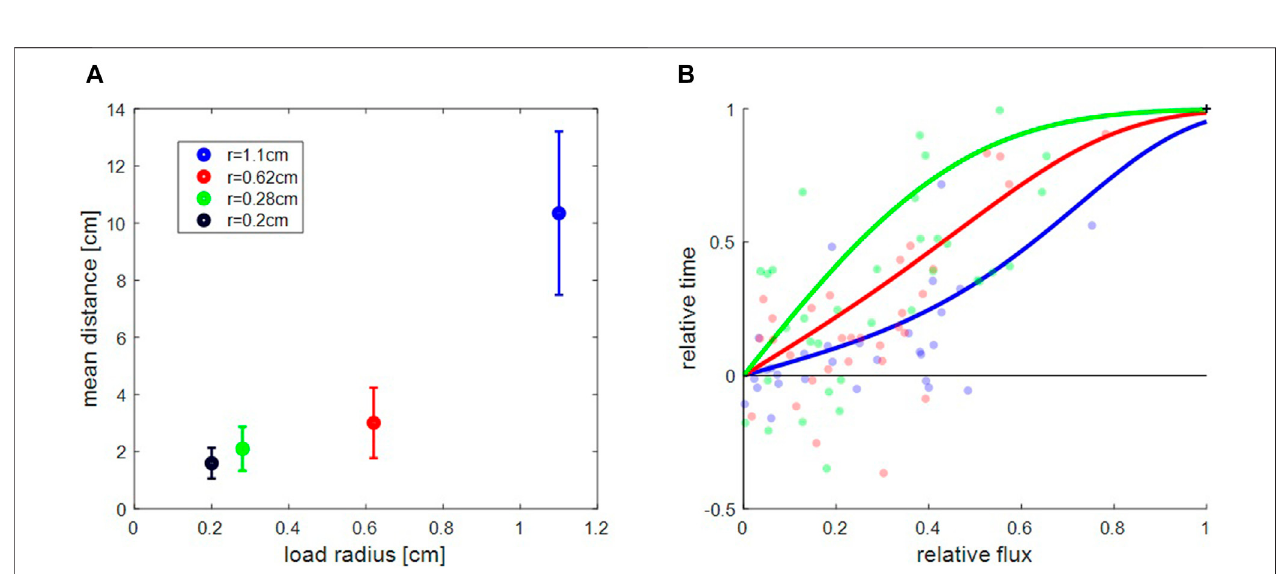
FIGURE 2 | Global properties of collective motions. (A) . Mean distance traveled toward closed side in one exit experiments as a function of load size. Presented values correspond to the length-scale ofthe exponential decay in the spatial distribution of the load away from the exit ( Figures 1A1,B1 ). Error-bars represent standard error of the mean over, from largest object to the smallest one, N (cid:1) 21 , 20 , 12 and six 15 min time windows. (B) . In two exit experiments, the relative time, T rel (cid:1) ( T H − T L ) / ( T H + T L ) , i.e. the normalized difference between the time spent at the exit with the higher ant in fl ux and that with lowerin fl ux, riseswiththe relative fl ux advantage of the majority entrance, f (cid:1) ( f − f ) / ( f + f ) . Curves are calculated theoretically for arun-and-tumble model ( Supplementary Equations S56 – S59 ), rel H L H L and rely on the exponential fi ts for the dependence of the turning probabilities ( λ ) on f rel ( Figure 3A ). Each experimental data point represents a 15 min window slice, where the fi lled circles represent two side experiments and the + symbols represent one side experiments. Color code as in panel (A) .